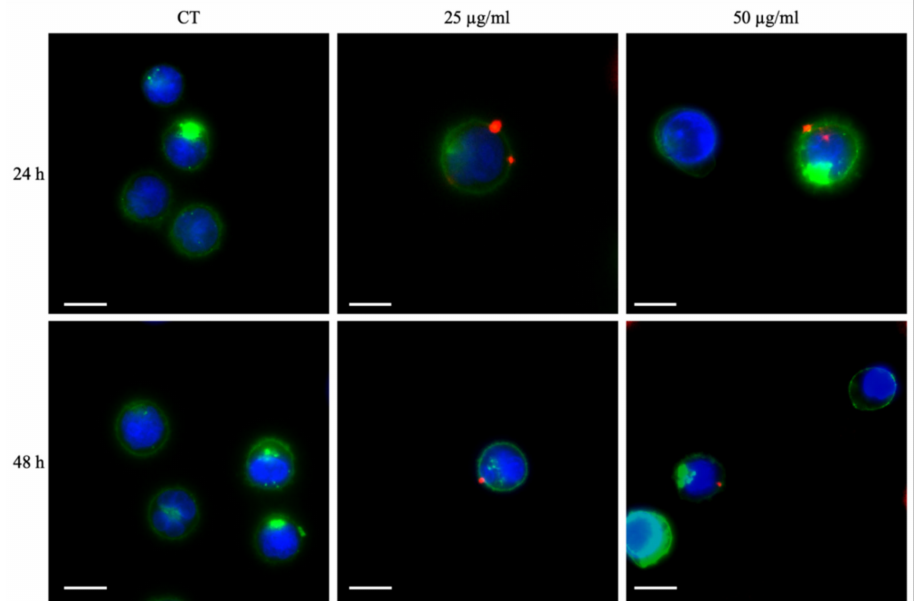
Figure 5. Fluorescence microscopy images of Daudi cells treated with different concentrations of TiO 2 -NH 2 /BSA NPs after 24 h and 48 h of incubation. Control cells without NPs (CT), cells incubated with 25 µ g/mL and cells incubated with 50 µ g/mL were analyzed. The blue channel represents the cells’ nuclei labelled with Hoechst, the green channel shows the cells’ membranes labelled with WGA488, and the red channel displays the NPs labelled with ATTO647. Scale bars are equal to 10 µ